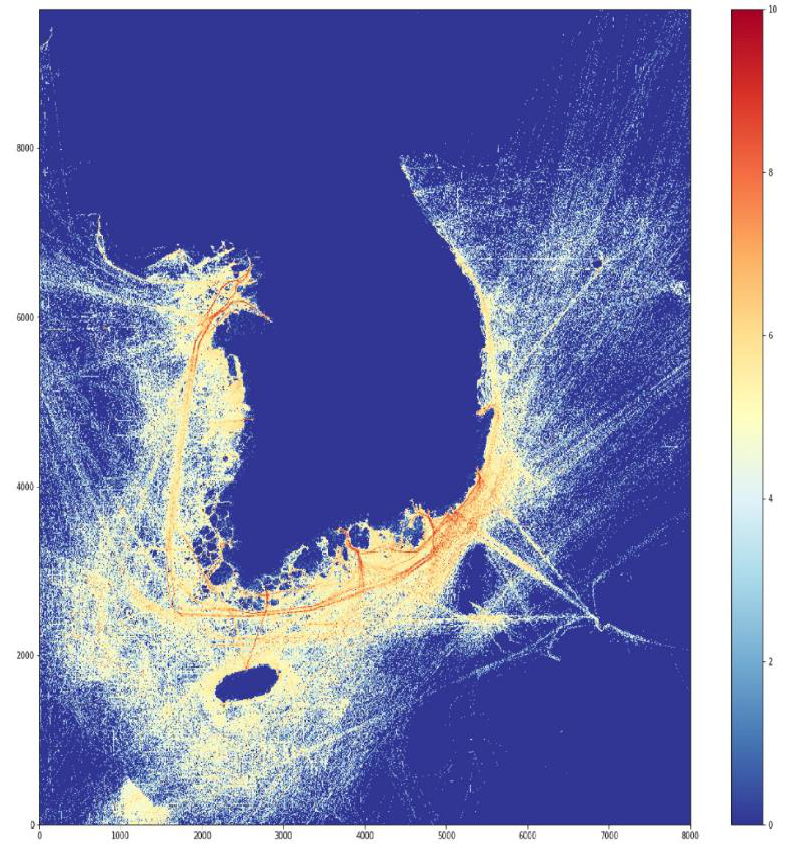
Figure 13. Vessel traffic status in Korean coastal waters reflecting the vessel traffic index.